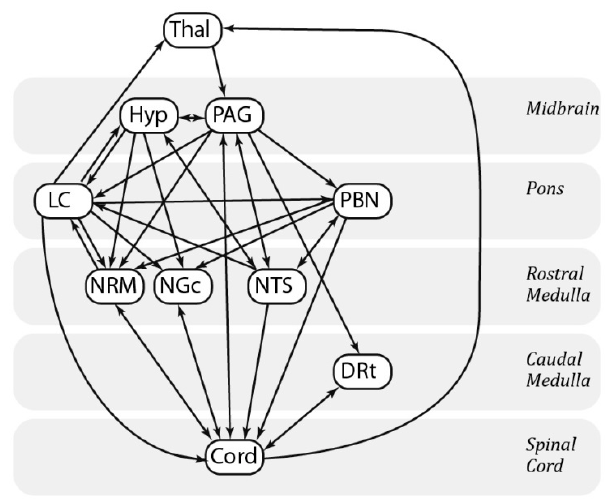
Figure 3. Anatomical model of the regions and connections used for the structural equation modelling (SEM) analysis.